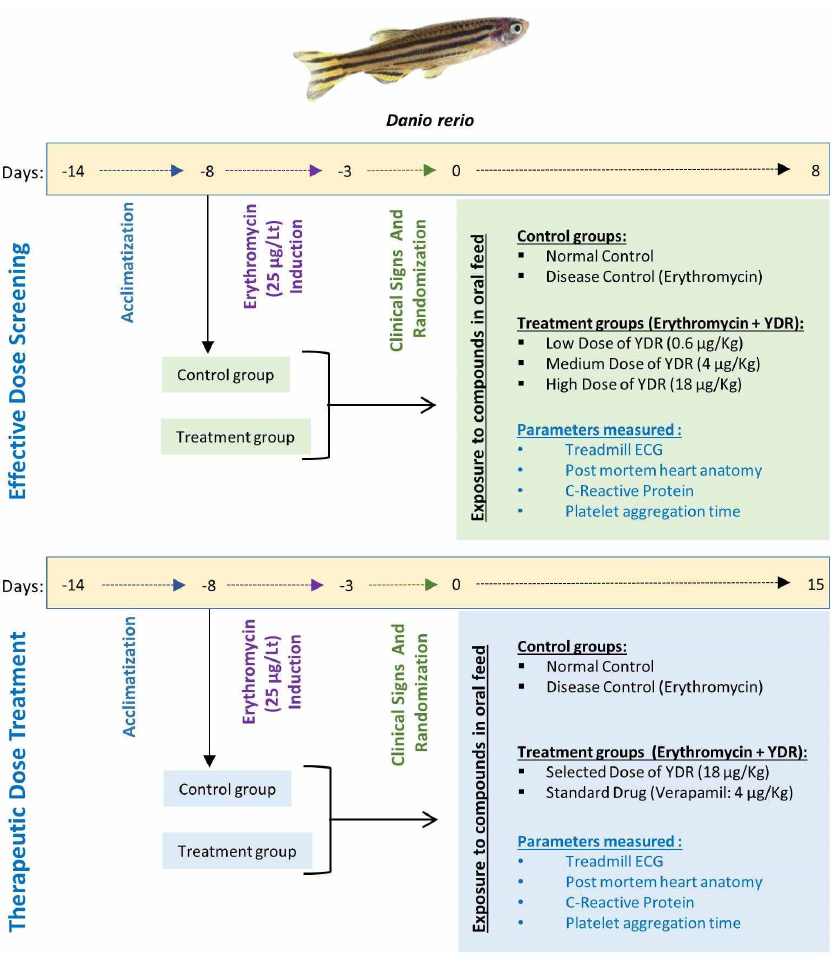
Figure 1. Experimental design of D. rerio exposure to cardiac hypertrophy induction by erythromycin. Duration of the effective dose study was 7 days, and for therapeutic dose study it was 14 days.